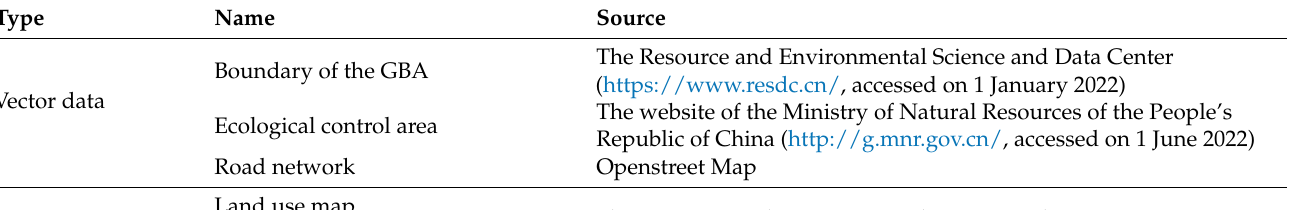
Table 1. Details of data used in the study.